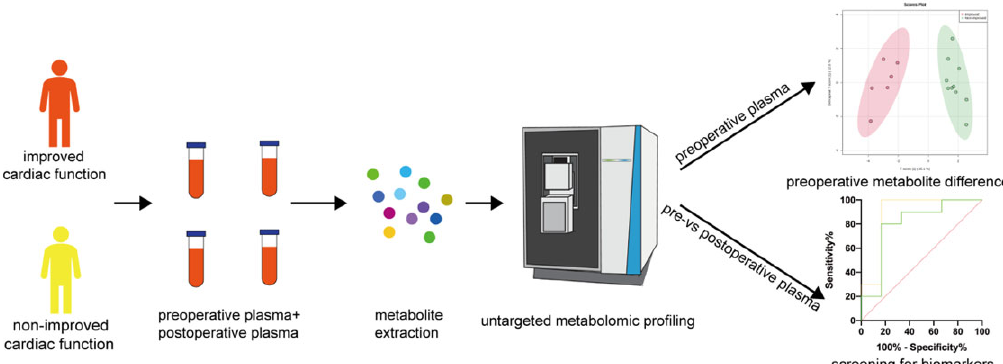
Figure 1. Schematic workflow of the present study.